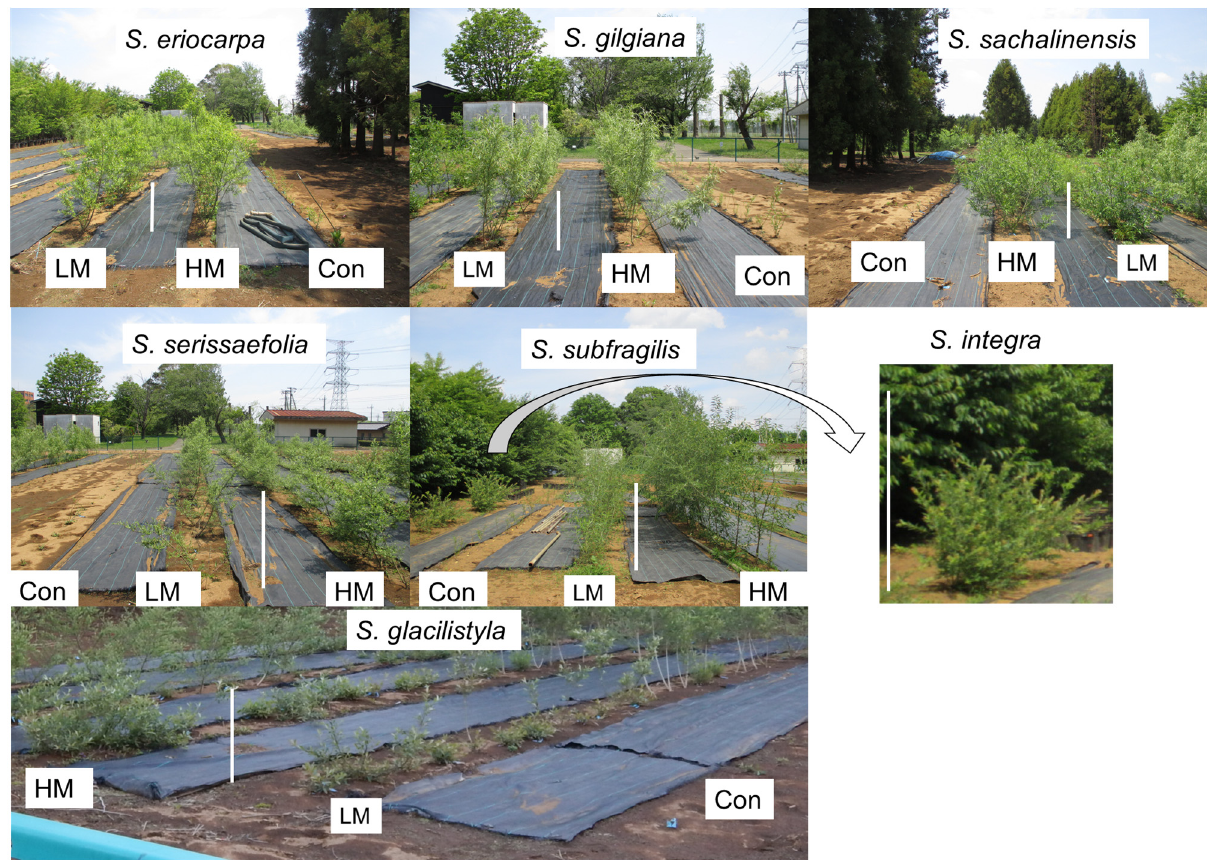
Figure 6. Pictures of seven willow species of three treatments 13 months after planting. The white line written in each picture was the scale of 1 m. The picture on the shrub of S. integra was not planted in this